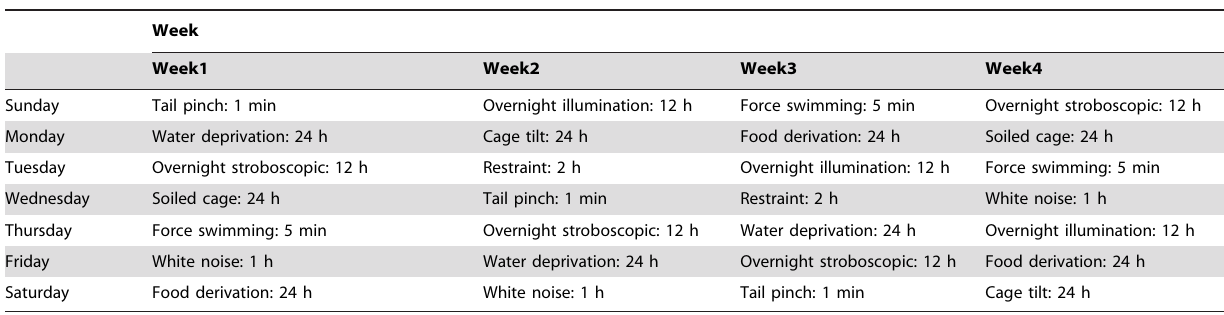
Table 2. The chronic unpredictable stress